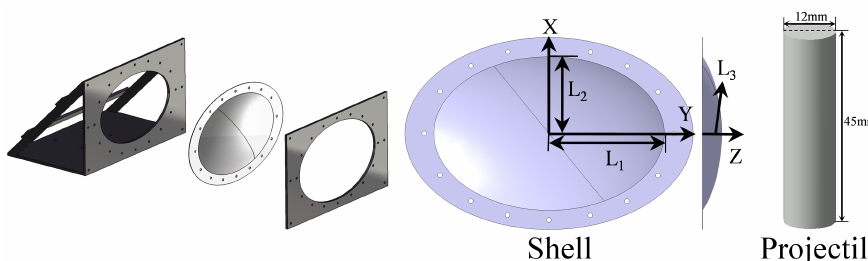
Figure 2. Configuration and sizes of